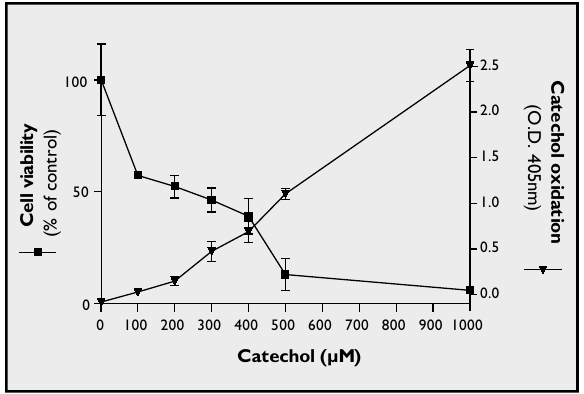
Figure 3 – Concentration-response curves for catechol-induced cytotoxicity and quinones formation in GL-15 cell cultures after 72h. Cell viability (  ) was determined by the MTT test and expressed as a percentage of control treated with 2 × 10 -5 M HCl. Each point represents the percentage of cell viability after treatment with catechol in several concentrations. The formation of quinones during the autoxidation of catechol was also measured by spectrophotometry at 405nm (  ). Data are represented by the mean ± SD, n = 5